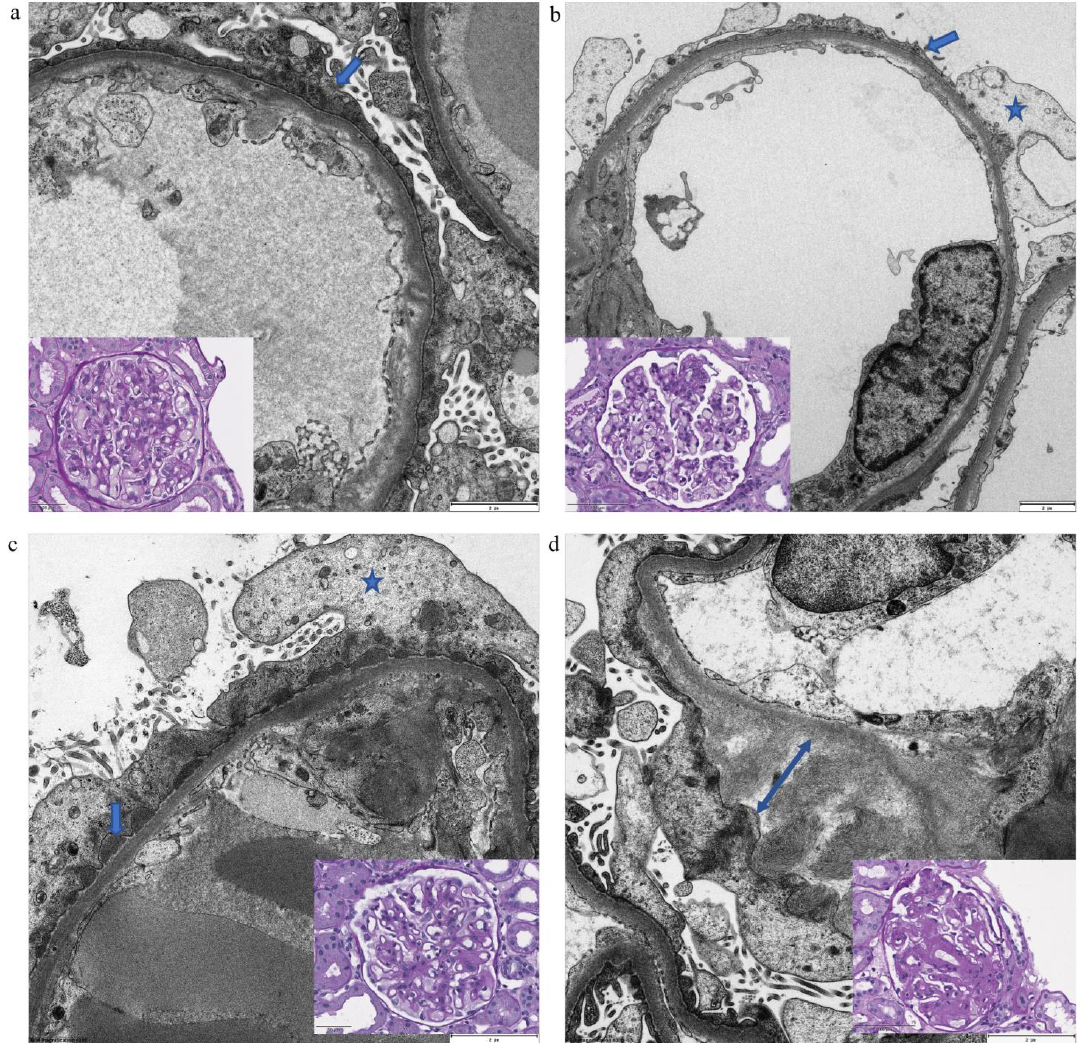
Figure 1. Ultrastructural image of primary and secondary podocyte damage. ( a ) Spreading of podocyte body on glomerular basement membrane (arrow) with retraction of foot processes in a case of MCD. ( b ) Extensive podocyte foot process effacement (arrow) and cytoplasmic vacuolization (star) in a patient with primary FSGS. ( c ) Foot process effacement (arrow), vacuolization and prominent organelles (double arrow) with underlying epimembranous electron-dense material (star) in primary membranous glomerulonephritis. ( d ) Subepithelial accumulation of amyloid-fibrils (two-head arrow) with consecutive podocyte detachment (as a sign of irreversible podocyte damage) in a patient with AL-amyloidosis (lambda). All electron micrographs are presented at 4000× magnification. Inserts — corresponding light microscopy photomicrographs (40×/0.65 NA; scale bar size: 50 µm in ( a , c , d ) and 100 µm in ( b ); PAS-staining).